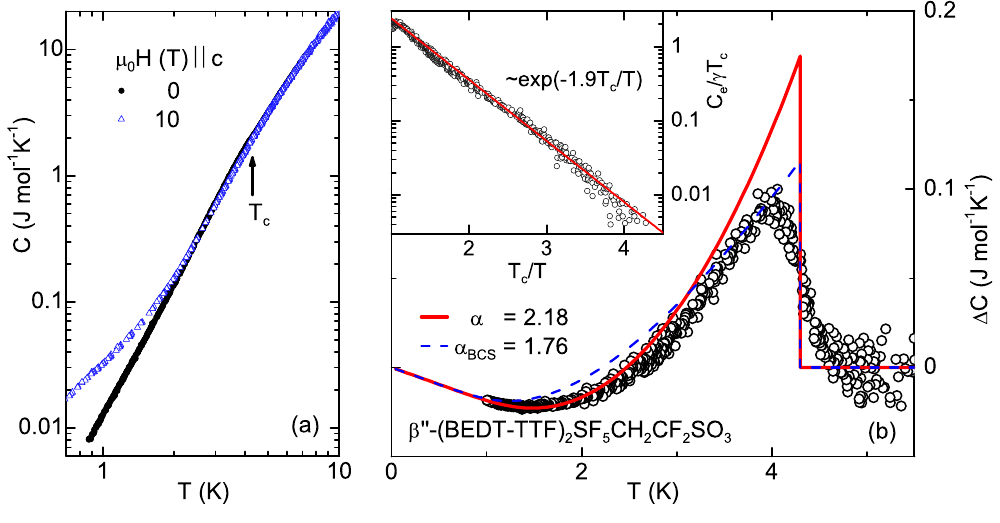
Figure 9. ( a ) Specific heat of (cid:12) ′′ -(BEDT-TTF) SF CH CF SO as a function of temperature 2 5 2 2 3 in a double-logarithmic scale. Data in the superconducting state in zero field and in the normal state at 10 T applied perpendicular to the BEDT-TTF planes are shown; ( b ) Temperature dependence of the specific-heat difference between the superconducting and normal state. The lines show the BCS behavior for weak coupling (dashed) [58] and strong coupling (solid) [59]. The inset shows the electronic part of the specific heat, C , e =T . The solid line shows the exponential vanishing of C divided by (cid:13)T as function of T c c e towards low